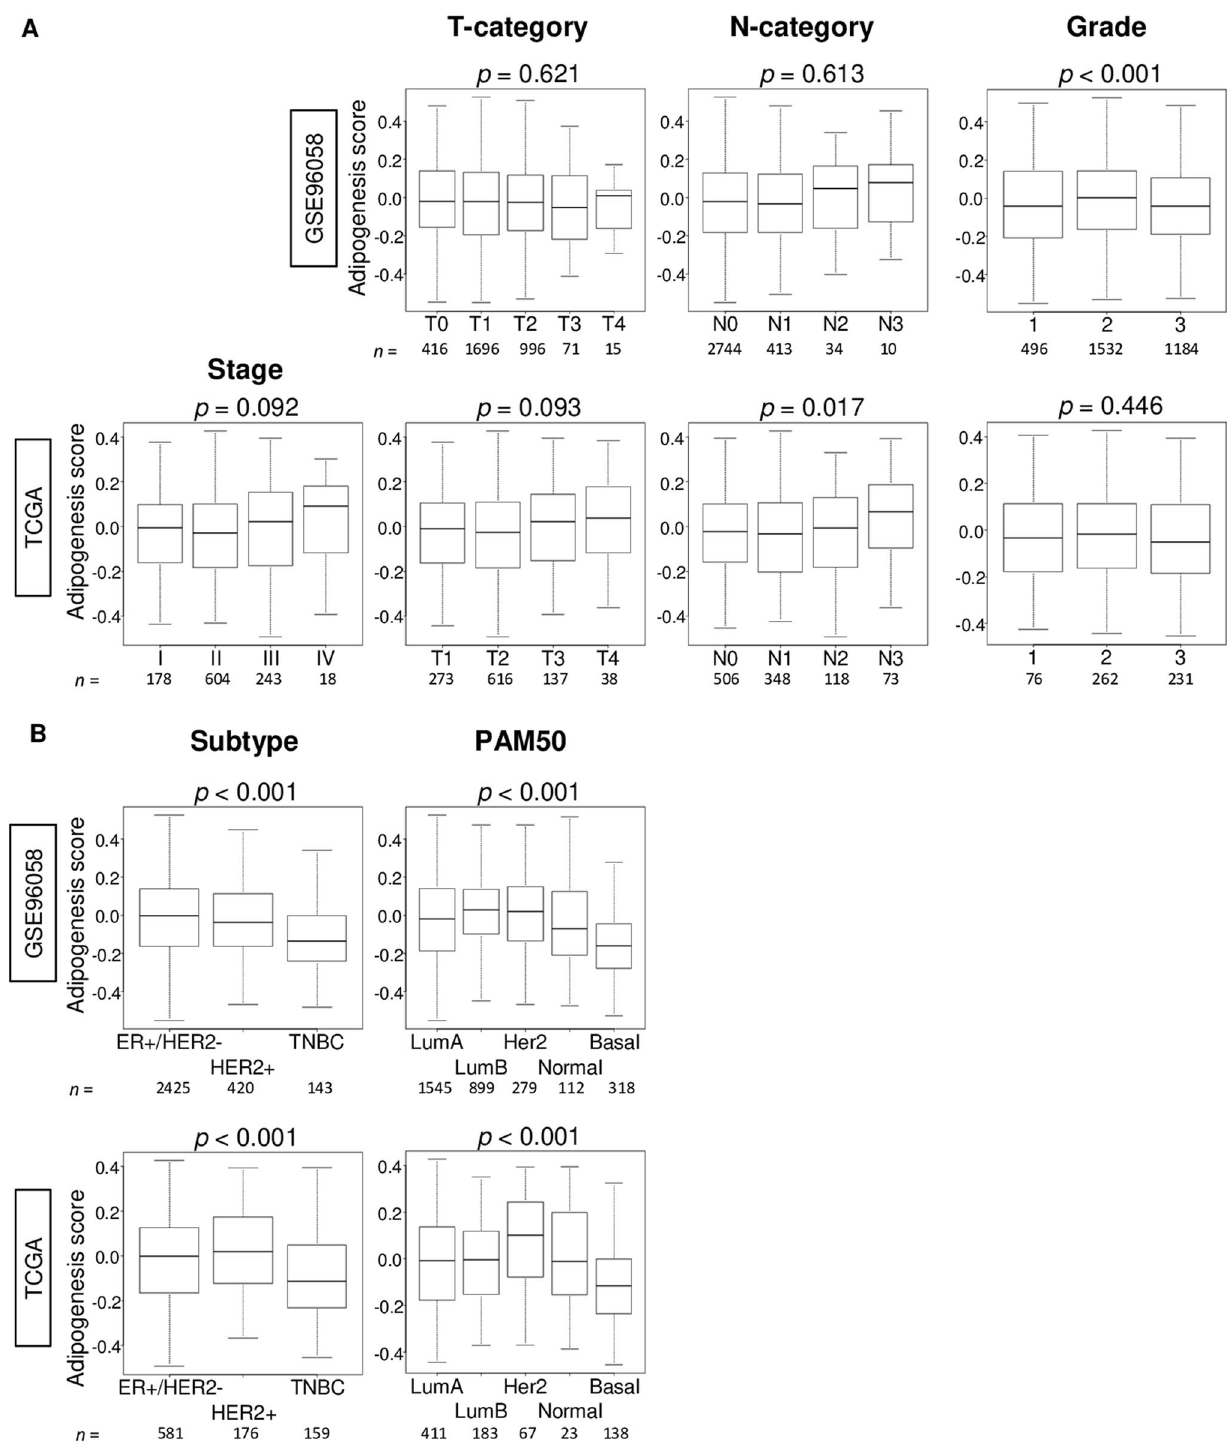
Figure 2. Association of the adipogenesis pathway score with clinical features in the GSE96058 and TCGA cohorts. Boxplots of the adipogenesis scores of tumors by (A) American Joint Committee on Cancer stage, tumor size (T-category) and lymph node positivity (N-category), Nottingham pathological grade, and (B) breast cancer subtype, and Pam50 classifications. P -value was calculated using Kruskal–Wallis test. Group sizes are shown underneath the